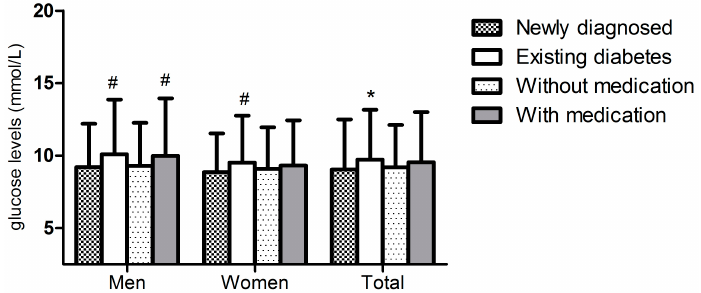
Figure 2. The average glucose levels of residents with newly diagnosed versus those existing diabetes and of those without and with medication. # means p < 0.05. * means p < 0.001.